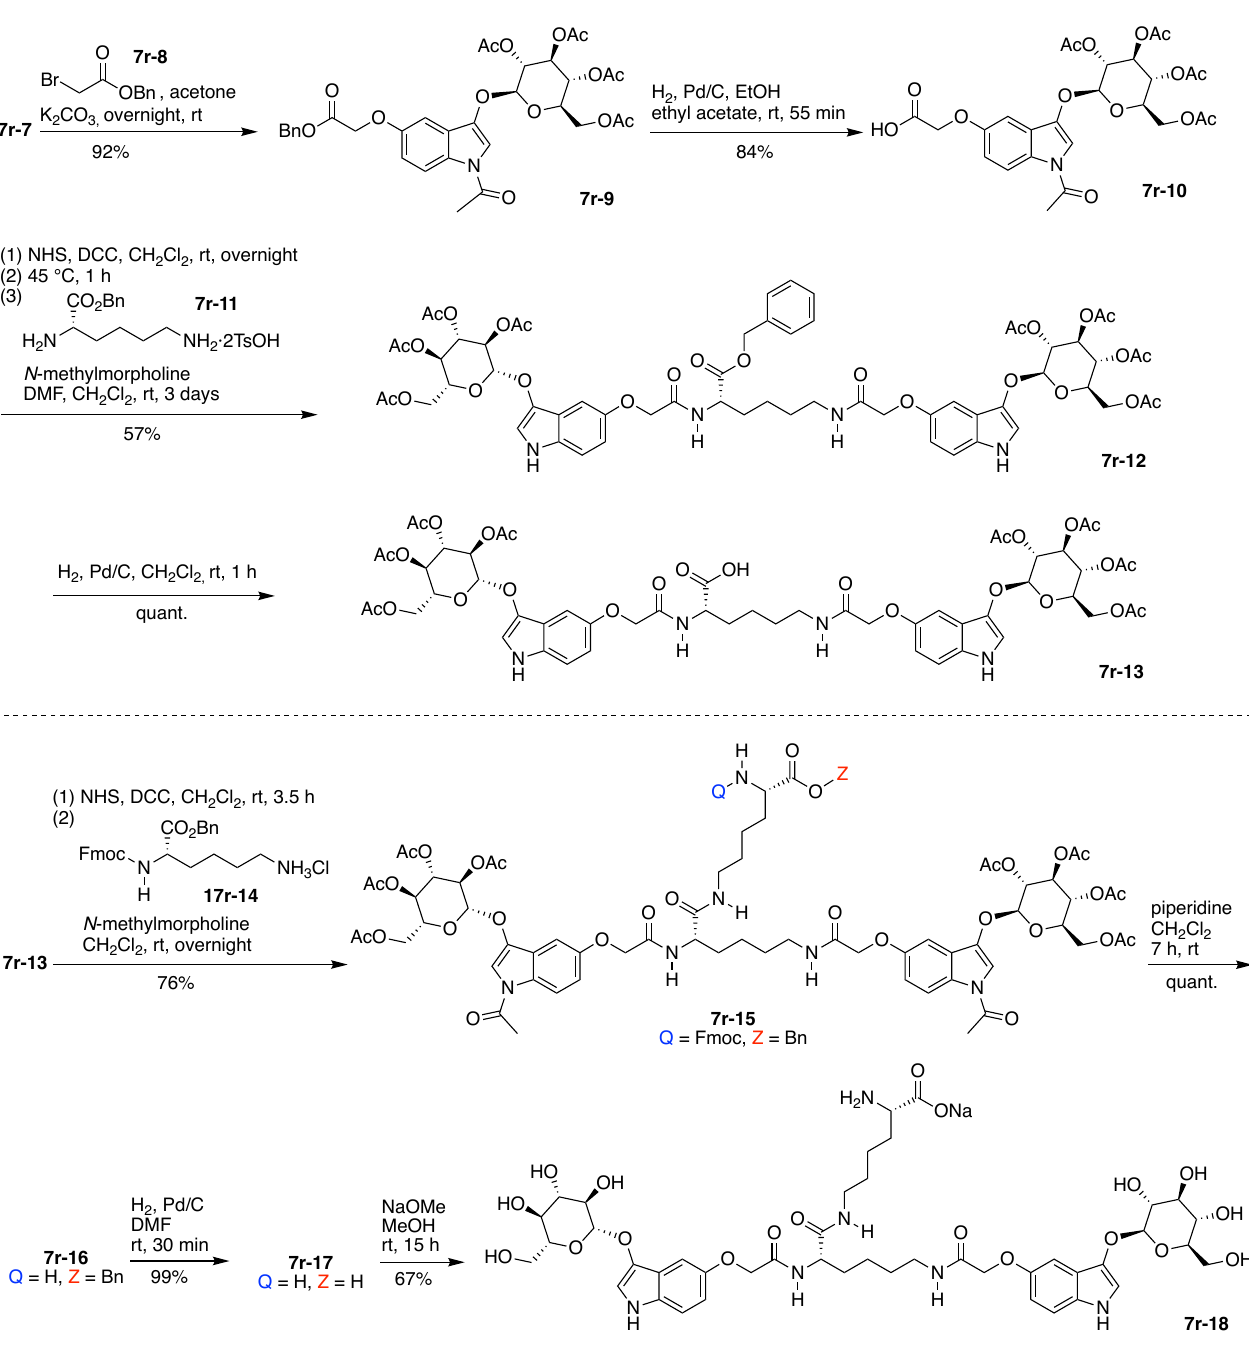
Figure 19. Synthesis of a Lys hub bearing two protected glucosyl-indoxyl moieties and extension of a second Lys hub. DCC-mediated coupling of 7r-13 with α-Fmoc- O -benzyl lysine ( 7r-14 ) gave 7r-15 , which upon removal of the Fmoc group with piperidine gave free amine 7r-16 . Hydro- genolysis of the latter gave the amino acid 7r-17 , and treatment with sodium methoxide caused global removal of the acetyl protecting groups from the glucoside ( O -acetyl) and the indoxyl ( N -acetyl) units to give 7r-18 , containing the free amine and carboxylate groups (Figure 19).